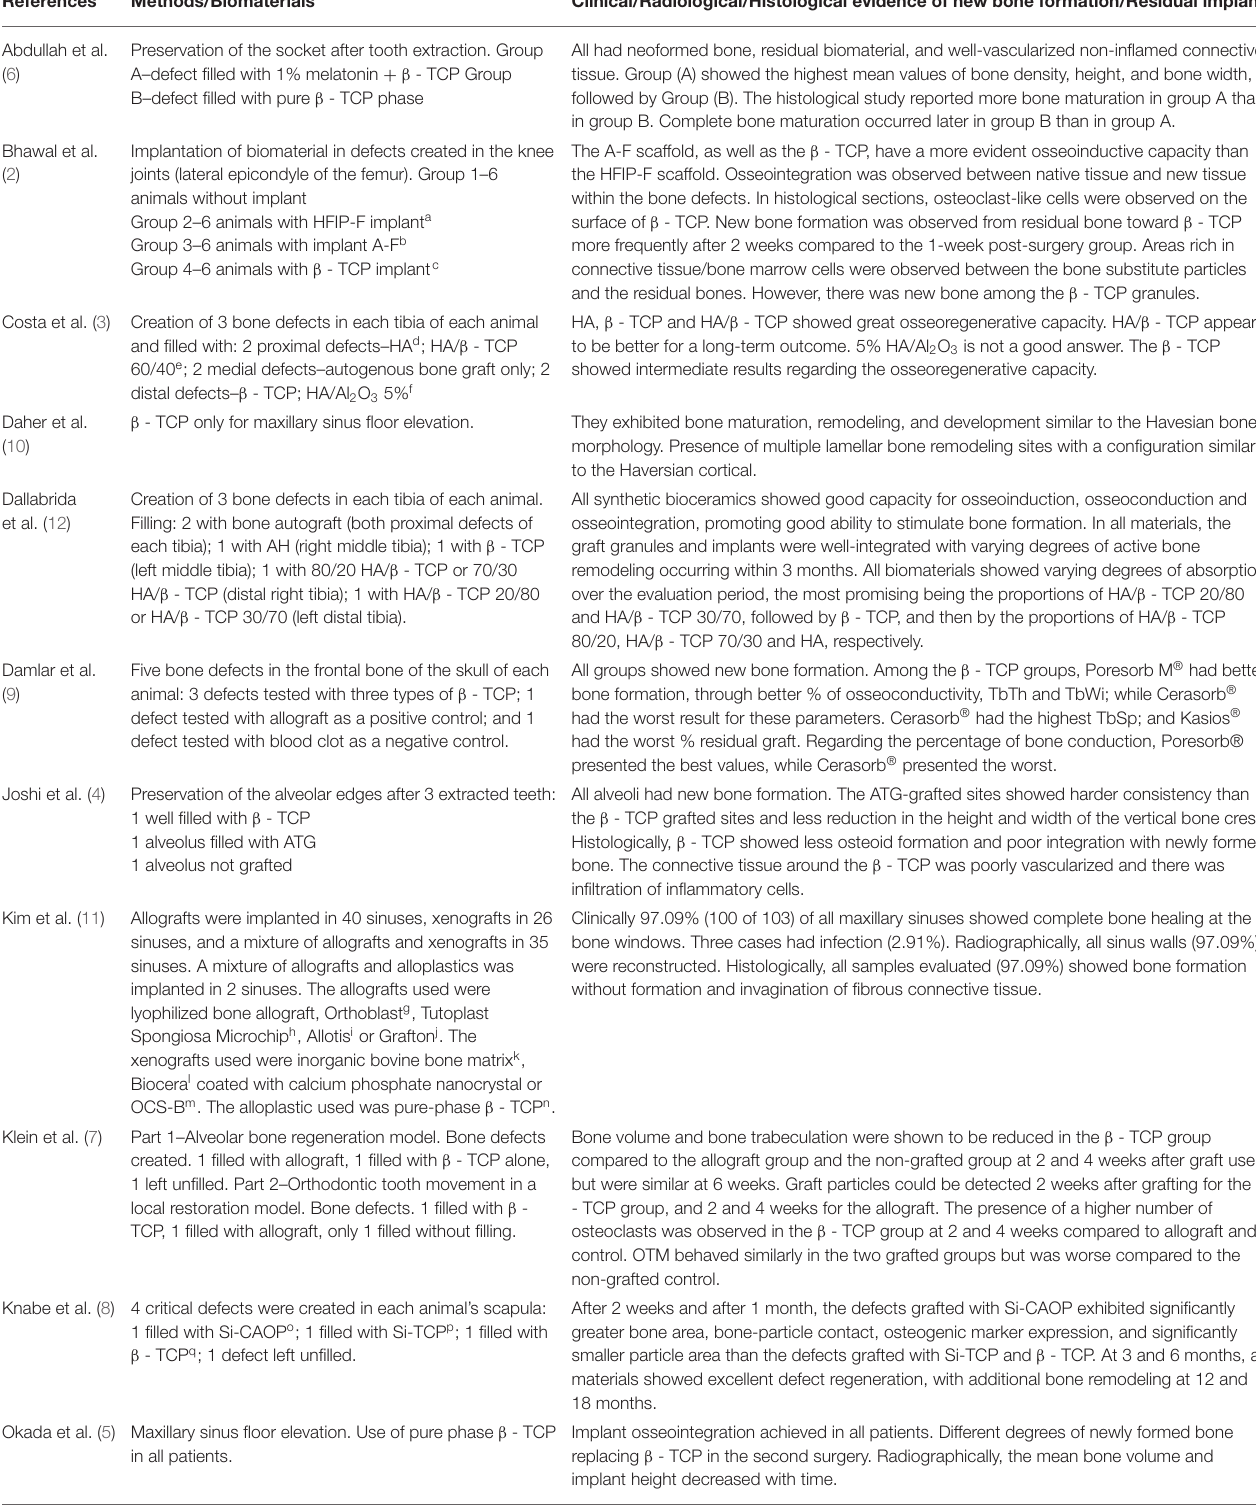
TABLE 2 | Articles in alphabetical order of authors included in the systematic review showing the methodology and biomaterials used, as well as the effectiveness of the studies demonstrated by clinical, radiological and/or histological evidence of new formed bone after placement of the